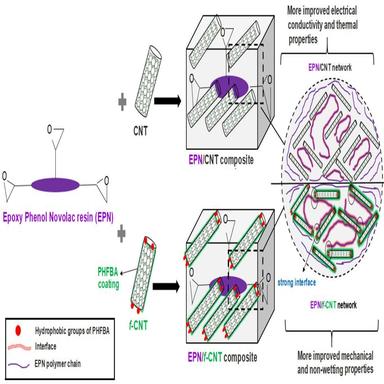
Effect of functionalization of CNT on composite's properties.